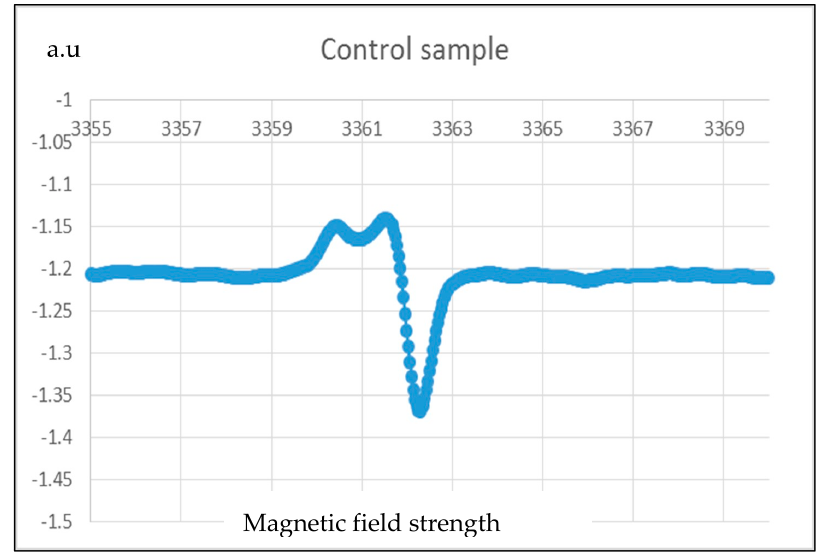
Figure 17. EPR results for control PVDF.